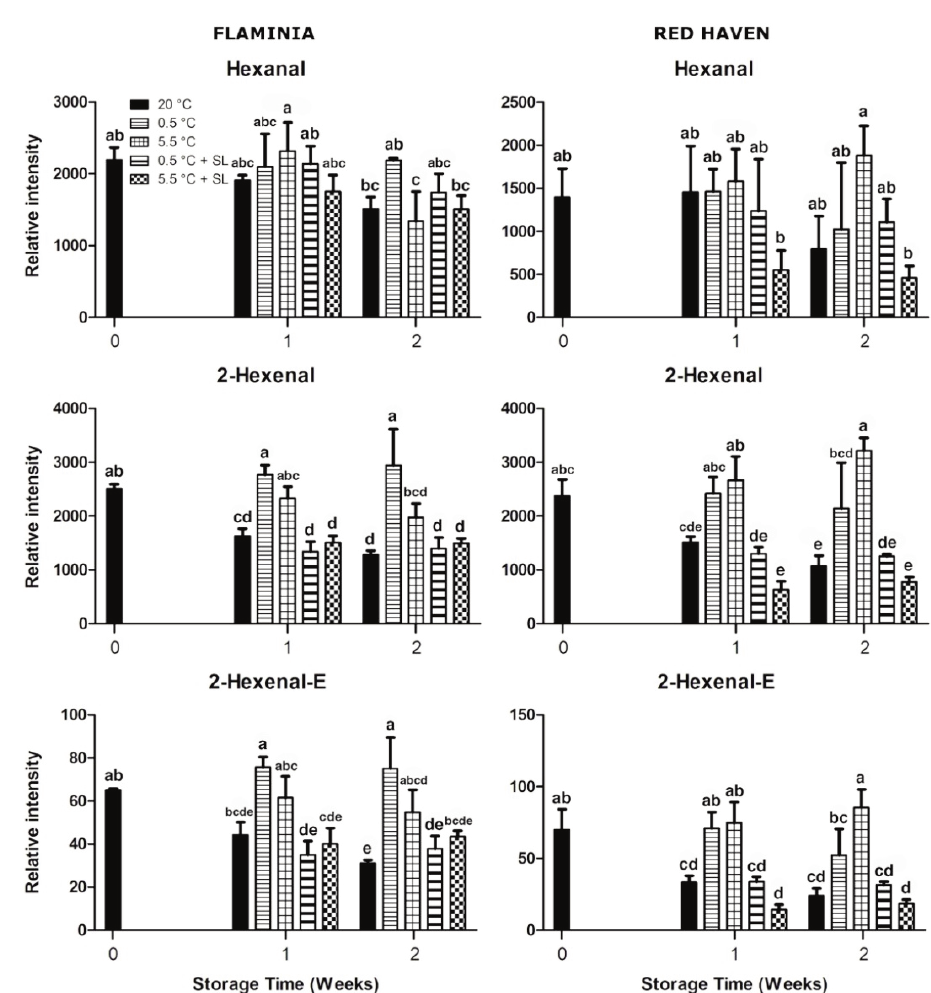
Fig. 1 ­ Analysis of targeted LOX pathway­derived aldehydes. Mesocarp samples (cv. Flaminia, left panel; cv. Red Haven, right panel) were analysed at harvest (0), at the end of 1 and 2 weeks of cold storage at 0.5 and 5.5°C, and after three additional days of shelf life (0.5 and 5.5°C + SL). Samples kept at 20°C represent the room temperature control. The average value of three biological replicates is reported with bars representing SD. Letters indicate the results of Tukey's Honest Significant Difference (HSD) post hoc test, performed independently for each